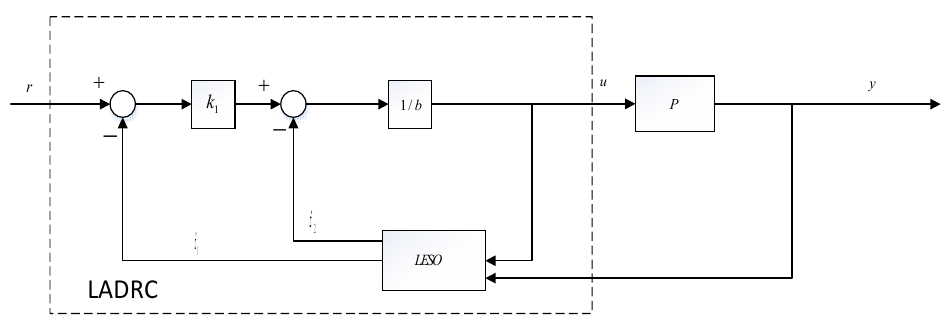
Figure 3. Structure of first-order LADRC.